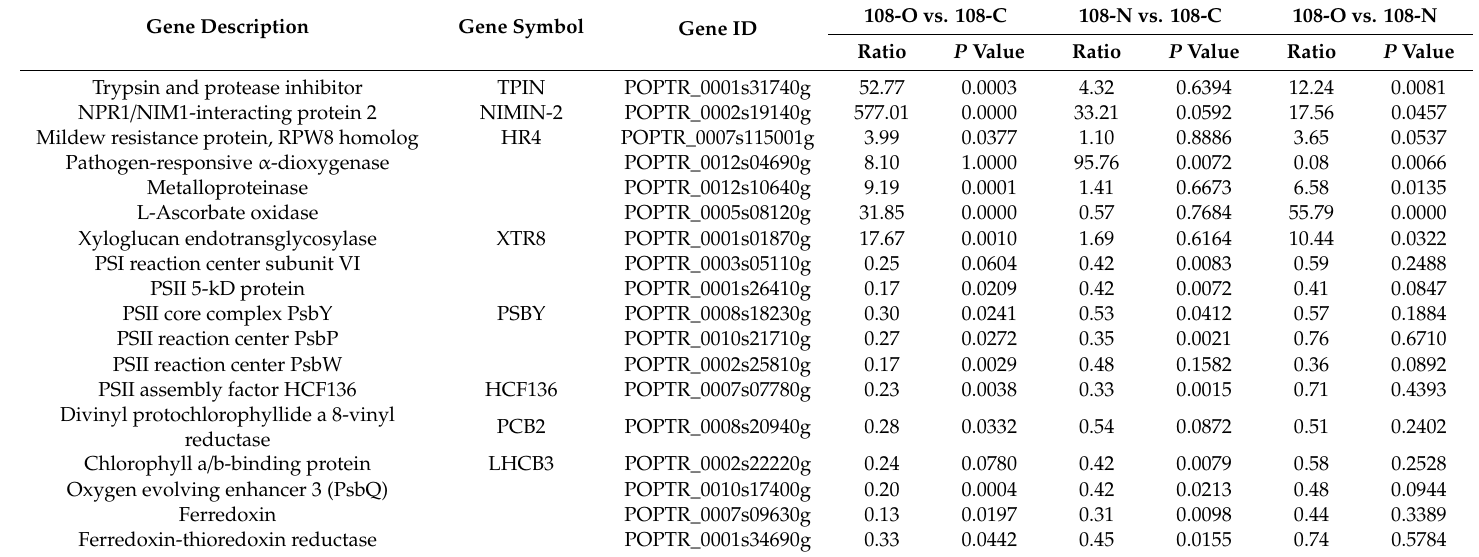
Table 3. Di ff erential gene expression of important defense genes among the ‘108’ treatment